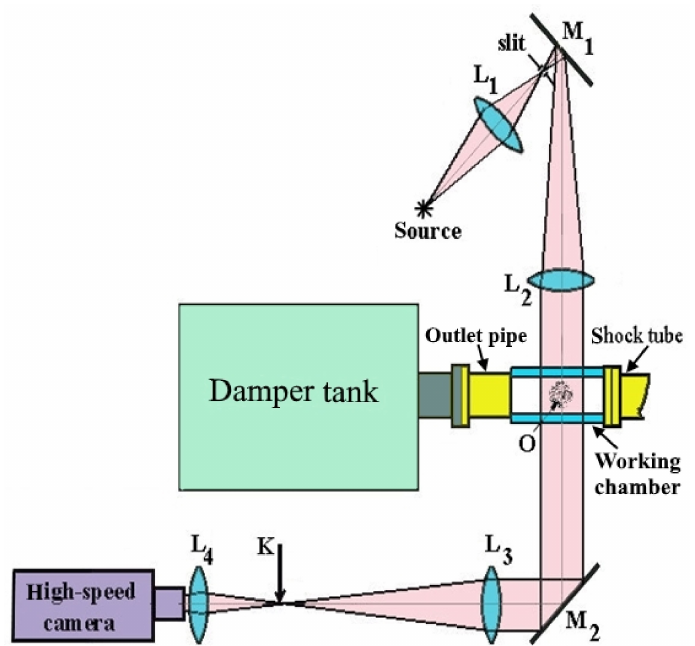
Figure 2. Optical layout of the Schlieren